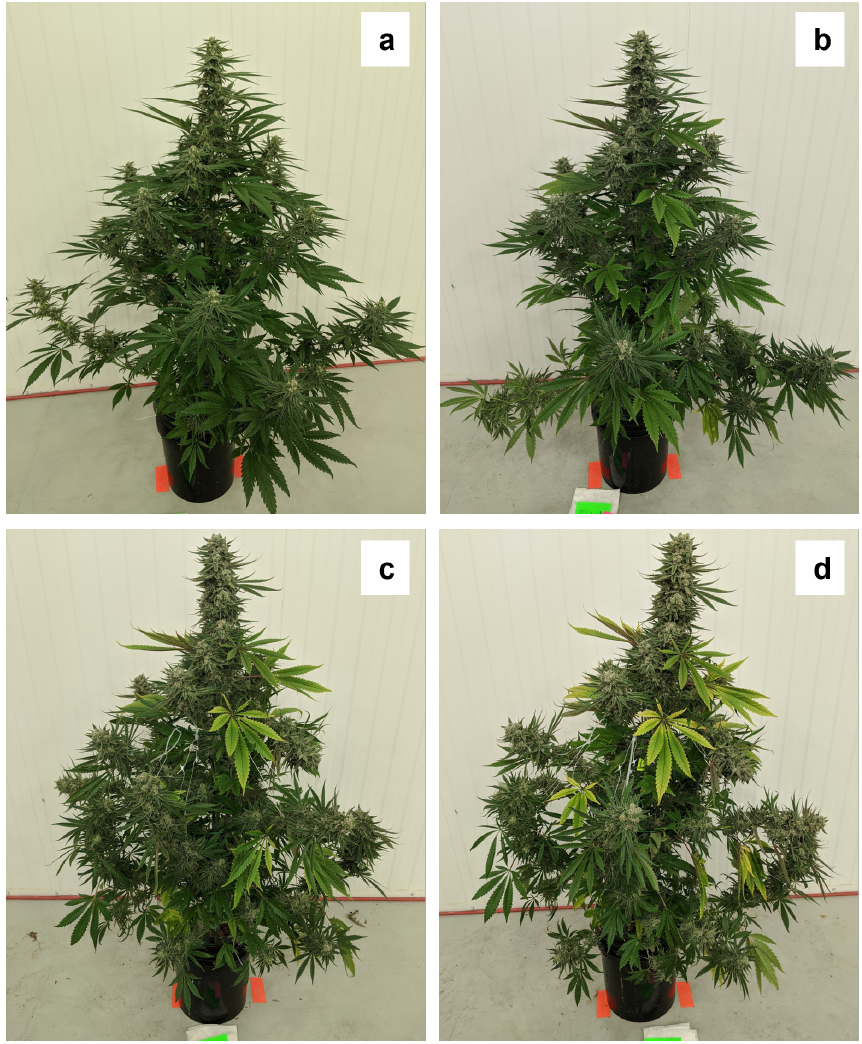
Figure 1. Control plant during ( a ) week five when no foliar deficiency symptoms were visible and ( b ) week six, ( c ) week seven, and ( d ) week eight, as fan leaves developed increasing levels of foliar